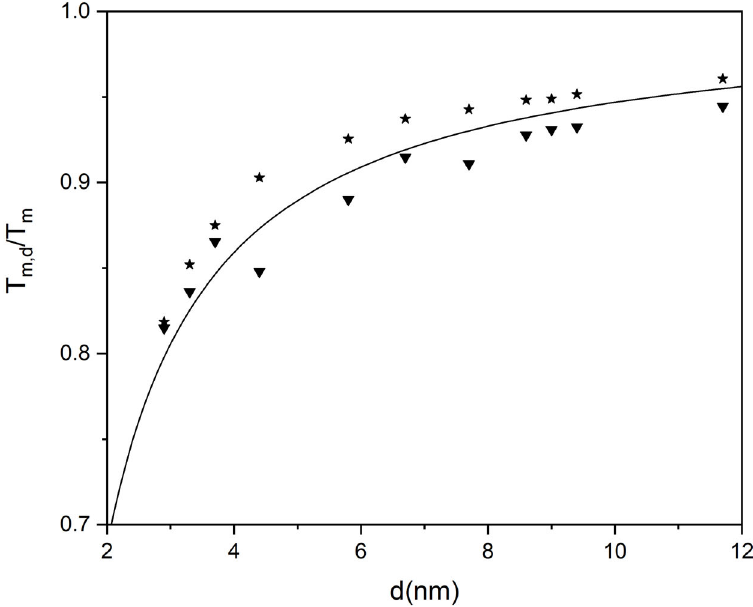
Figure 3. Experimental [28] freezing temperatures ( ▼ ), melting temperatures ( ⁕ ), and calculated ( ▬ ) transition temper ‐ atures per Equation (12) as a function of the pore diameter.